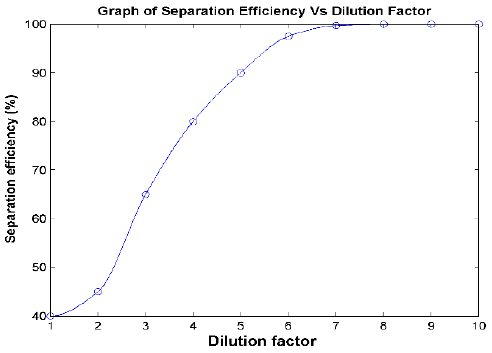
Figure 14. Graph of separation efficiency vs. dilution ration in the MAP stage.